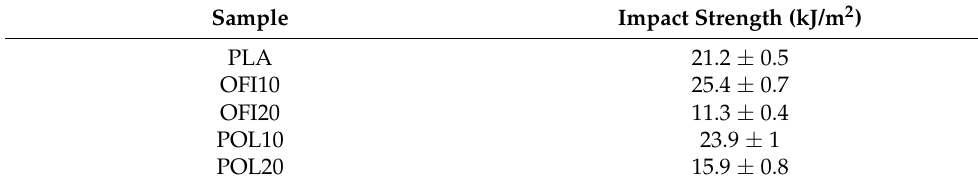
Table 5. Impact properties of the 3D printed samples.